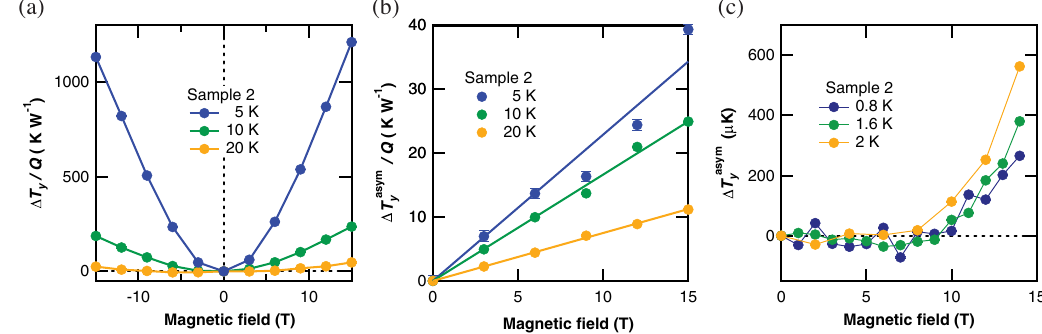
=Q Þ . The zero-field y